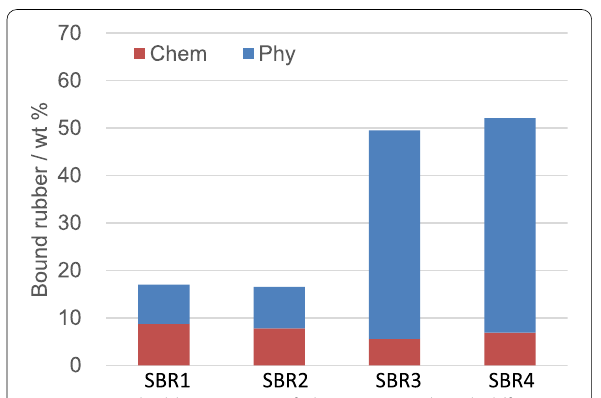
Fig. 15 Bound rubber contents of silica compounds with different types of SBRs (linear type)